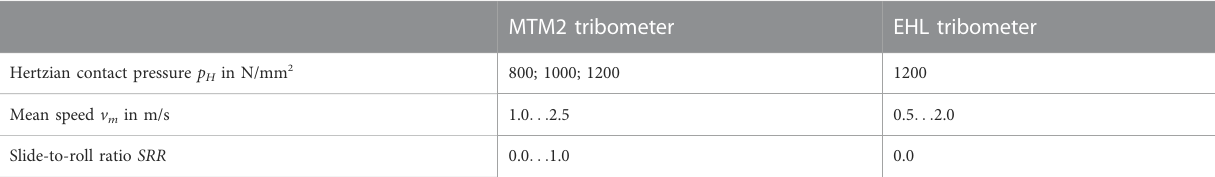
TABLE 2 Operating conditions at MTM2 and EHL